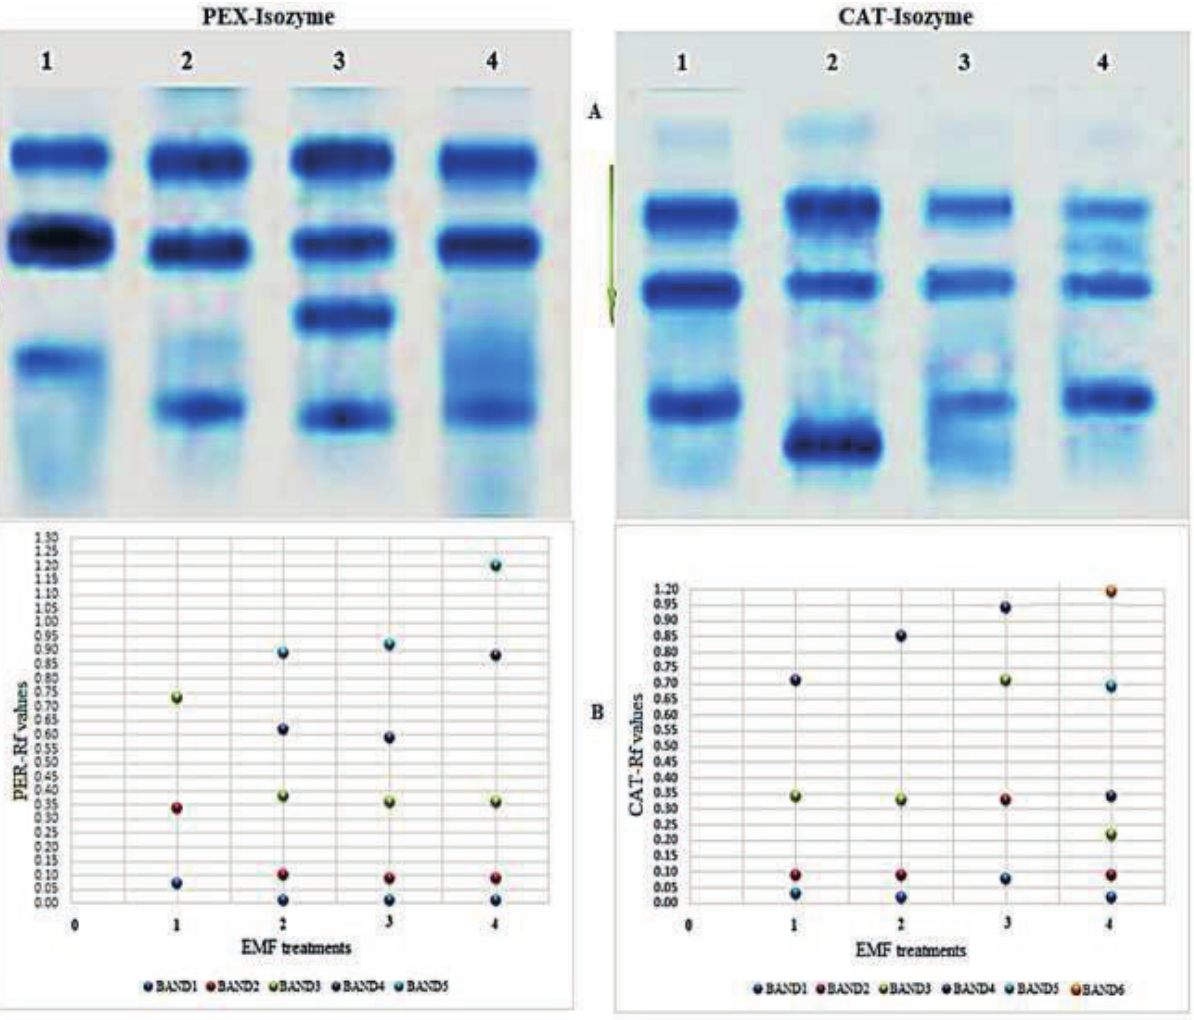
Figure 3. (A) Isozymatic patterns and (B) schematic distribution of Peroxidase (PEX) and Catalases (CAT) zymograms (R f values) of non- exposed and EMR exposed seedlings of Zea mays for days of exposure times (Ex-0, Ex-1, Ex-3,and Ex-5) based on relative front (R f ) Values and optical densities (OD). Lanes 1–4 represented the days of exposure times (Ex-0, Ex-1, Ex- 3,and Ex-5),